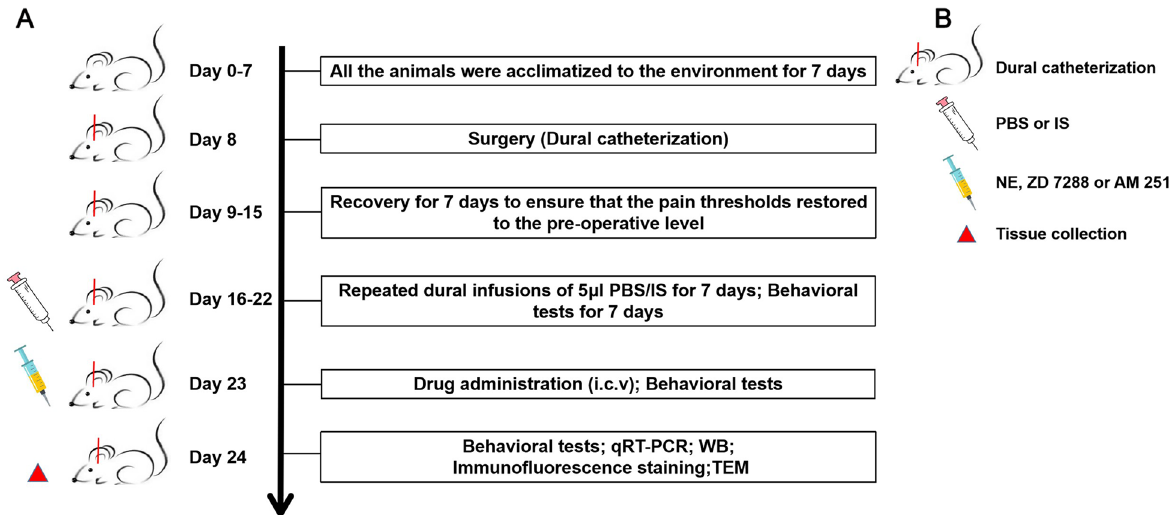
Fig. 1 The timeline and experimental steps in this research. Rats were randomly assigned to the experimental groups after 7 days of acclimatization. On the 8th day, rats underwent surgery for the establishment of the CM model, and rats with dura damage during the surgery were excluded. From the 9th day, rats were allowed to recover for 7 days to ensure that the pain thresholds were restored to the preoperative level. From the 16th day, rats were subjected to dural infusions of 5 μl of PBS/IS and behavioral tests for 7 days. On the 23rd day, rats were treated with intraventricular drug injections, and behavioral tests were performed. On the 24th day, after behavioral tests were performed, and rats were euthanized for the qRT–PCR, western blotting, immunofluorescence staining, and